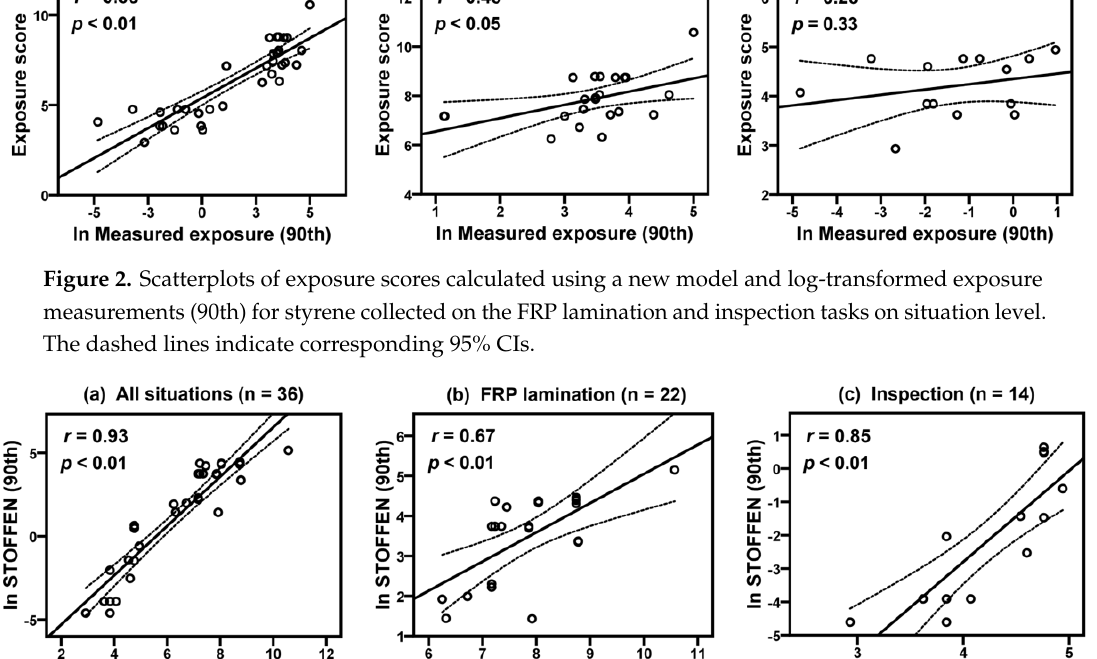
Figure 4. Residual plots of the differences between the log-transformed model estimations (daily average or 90th) of Stoffenmanager and exposure measurements for styrene collected on the FRP lamination and inspection tasks on individual level. The mean differences with 95% upper and lower limits of agreement are marked with the dashed lines. 4. Discussion In this study, we characterised styrene exposure levels collected in industrial spraying and coating situations in the FRP lamination process in various industries in Korea, sometimes exceeding 20 ppm which is the current KOEL, but they were relatively low in the inspection situation. The Stoffenmanager